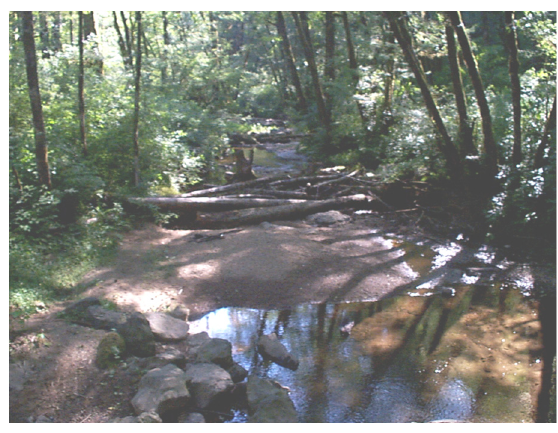
Figure 8. Large wood placed to reduce channel incision in West Millicoma Creek, Oregon.